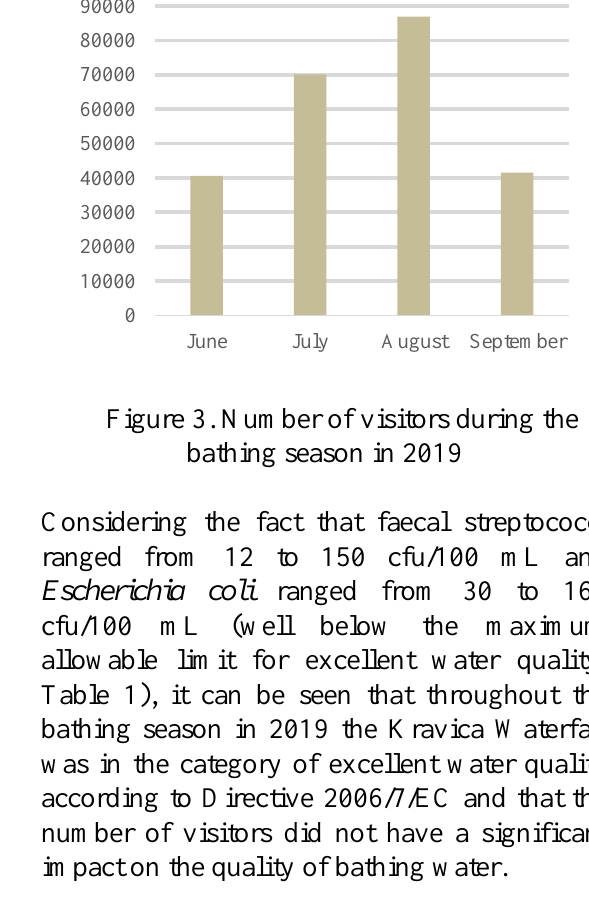
Table 3. Microbiological analysis of samples from 2019 (measuring unit